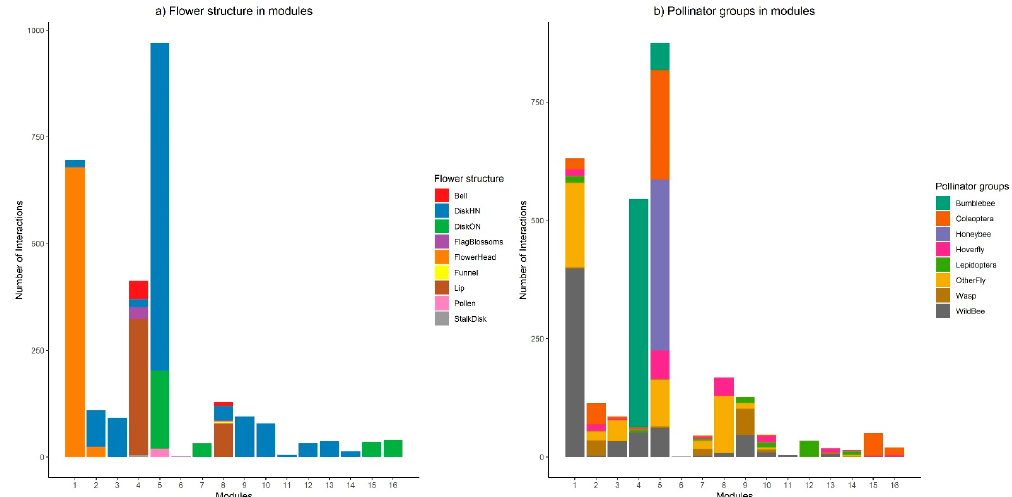
Figure 5. Bar graph showing the abundance of interactions involving different ( a ) plant and ( b ) pollinator functional groups across modules.